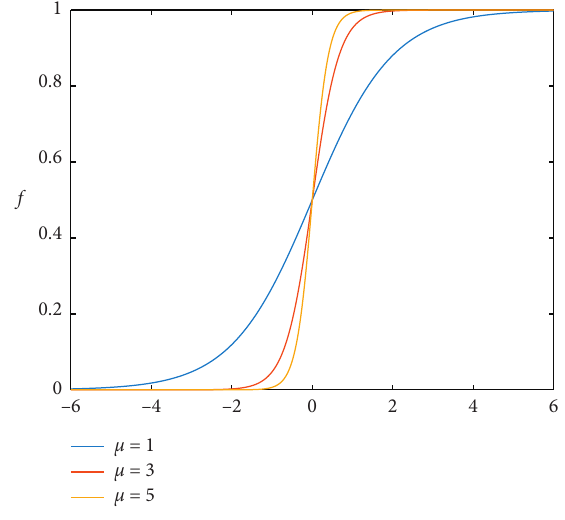
Figure 3: Logistic function.